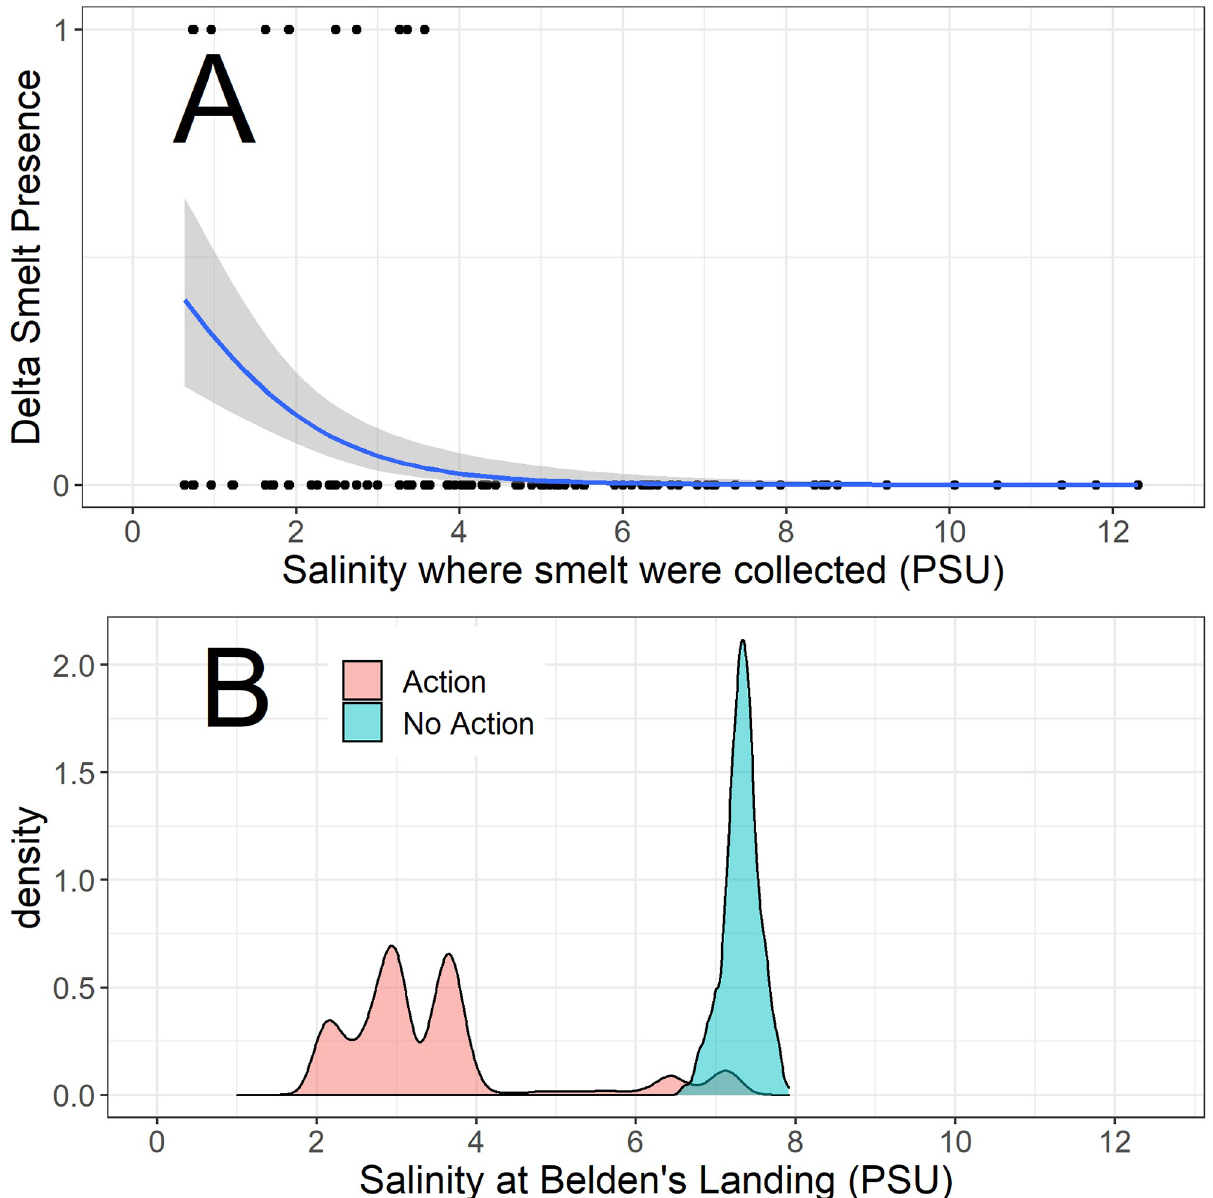
Fig 11. A: Comparison of historical (2002–2017) August Delta Smelt TNS catch data for Suisun Marsh in relation to measured salinities during the surveys. A binomial model was fitted to develop the relationship, (p < 0.0001). B: Distributions of modeled August 2018 salinities with and without the Flow Action. The modeled salinities are for Beldens Landing, a location central to Suisun Marsh and TNS